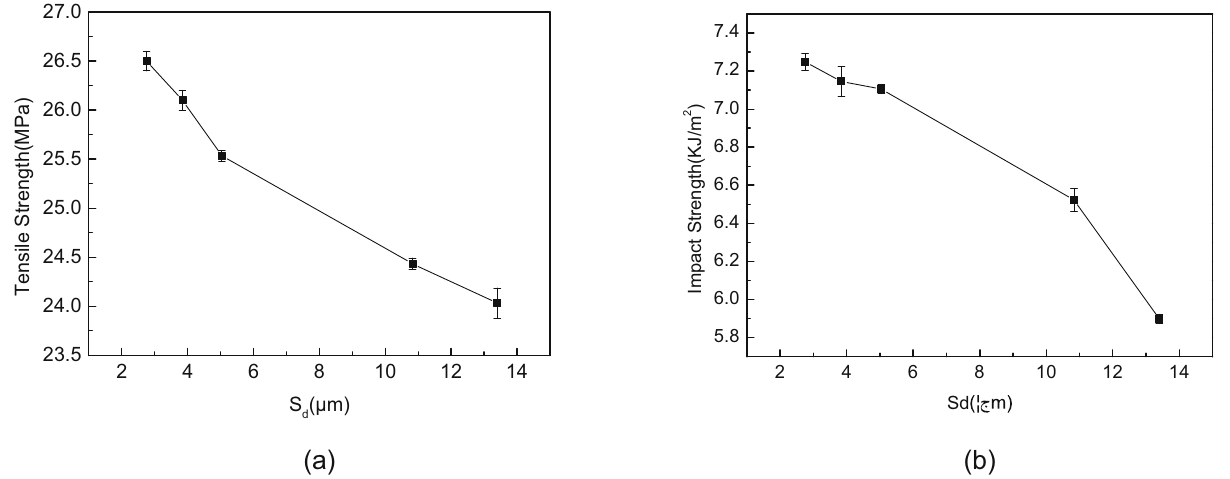
Figure 5: Correlation of mechanical behaviors and cell dispersion ( S d ) for foamed PP/OMMT composites: ( a ) tensile strength and ( b ) impact